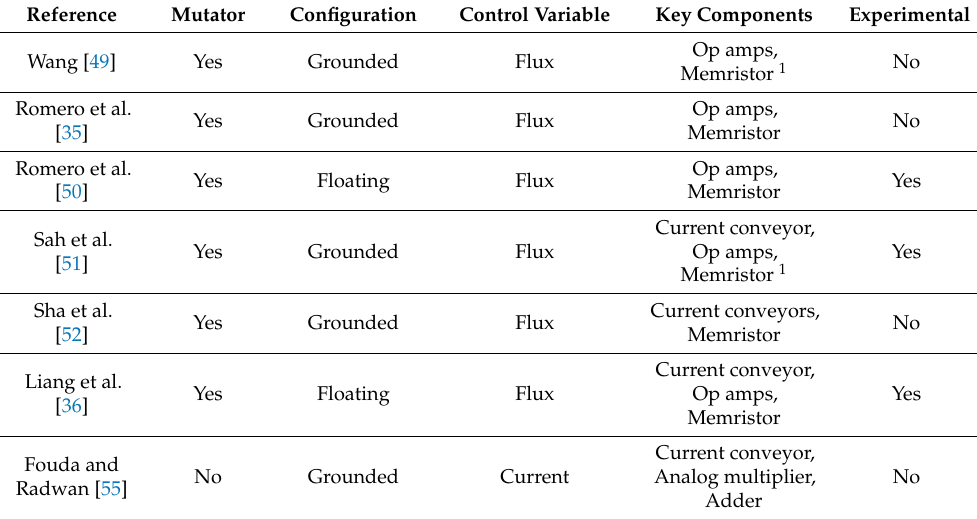
Table 2. Comparison of the different meminductor emulators presented in this